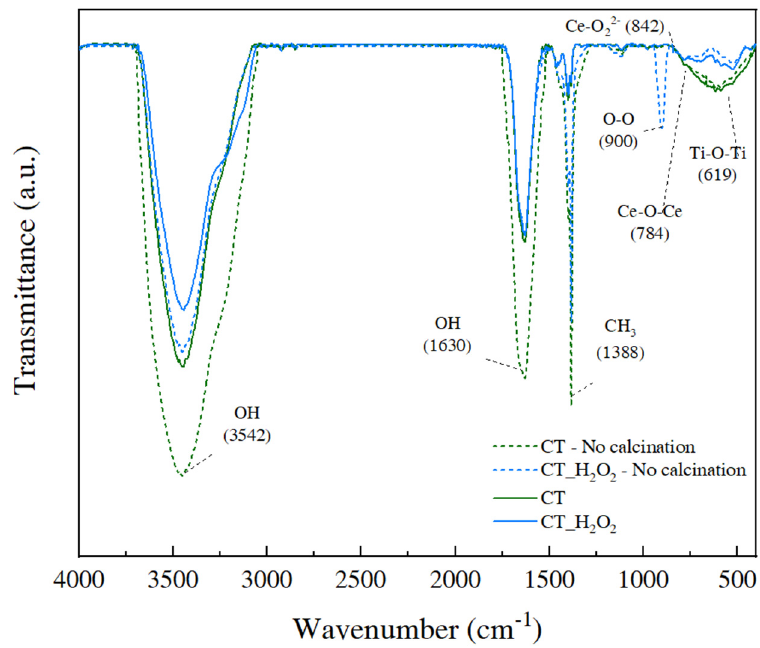
Figure 3. FTIR spectra of CT and CT_H 2 O 2 before calcination.